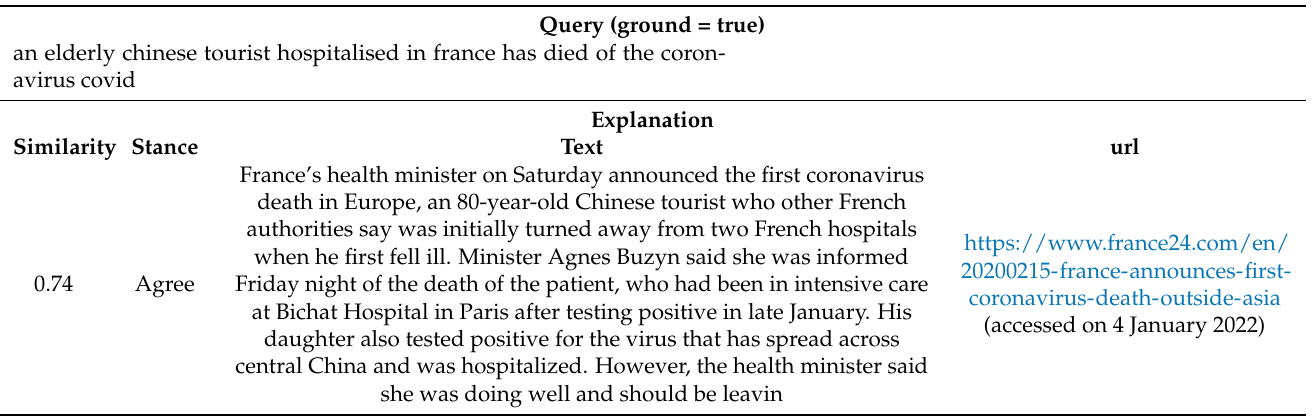
Table 4. Examples of answers provided by the system for different input queries (case study n. 2). Example